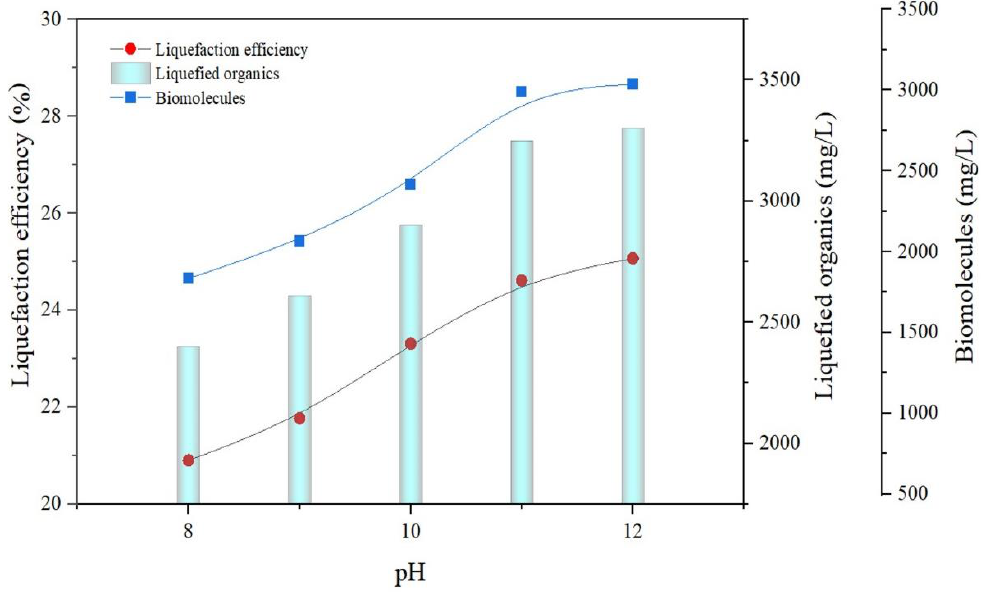
Figure 3. Impact of SAL on LOR and biomolecule release. Table 1. Composition of biomolecules at various pH levels.